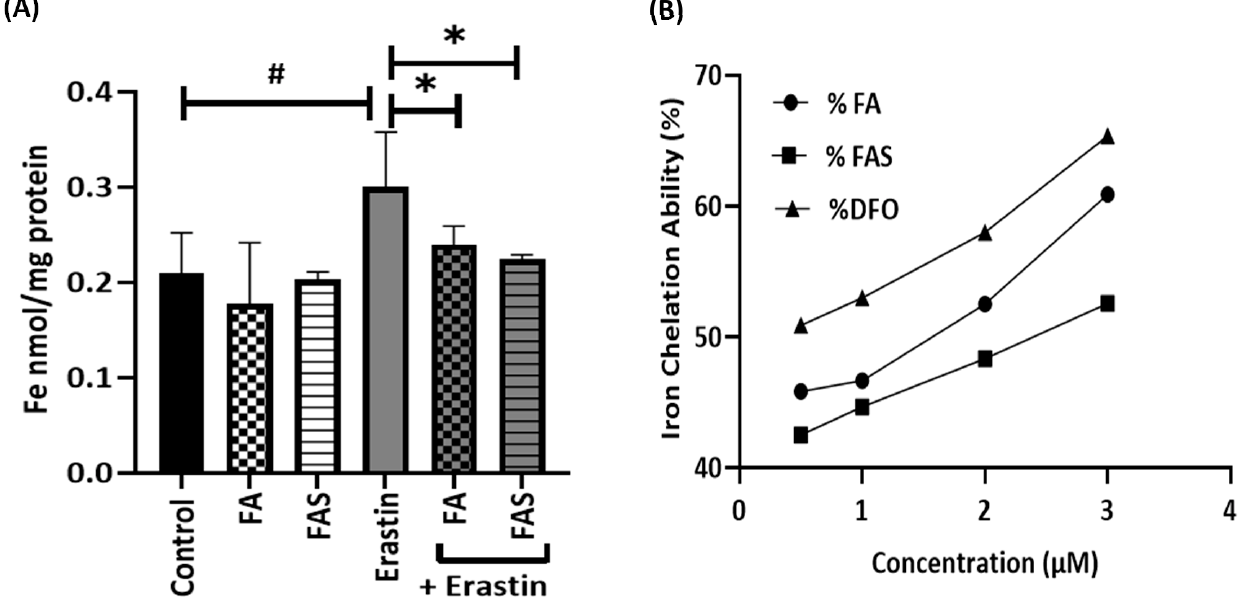
Figure 3. The iron-chelating capability of FA and FAS in MIN6 cells. ( A ) Cells were treated with 20 µ M of erastin in the absence and presence of 20 µ M of ferulic acid (FA) or ferulic acid 4-O- sulfate disodium salt (FAS) for 24 h. Then, iron concentrations were measured by ICP-MS analysis. ( B ) Different concentrations of FA, FAS, and deferoxamine (DFO) (0.5 µ M, 1 µ M, 2 µ M, and 3 µ M) were analysed to show iron chelation ability. All the values are expressed as the mean ± SEM. # p < 0.05 control vs. treatment groups; * p < 0.05 erastin only vs. treatment groups. One-way ANOVA, Tukey’s post hoc test.